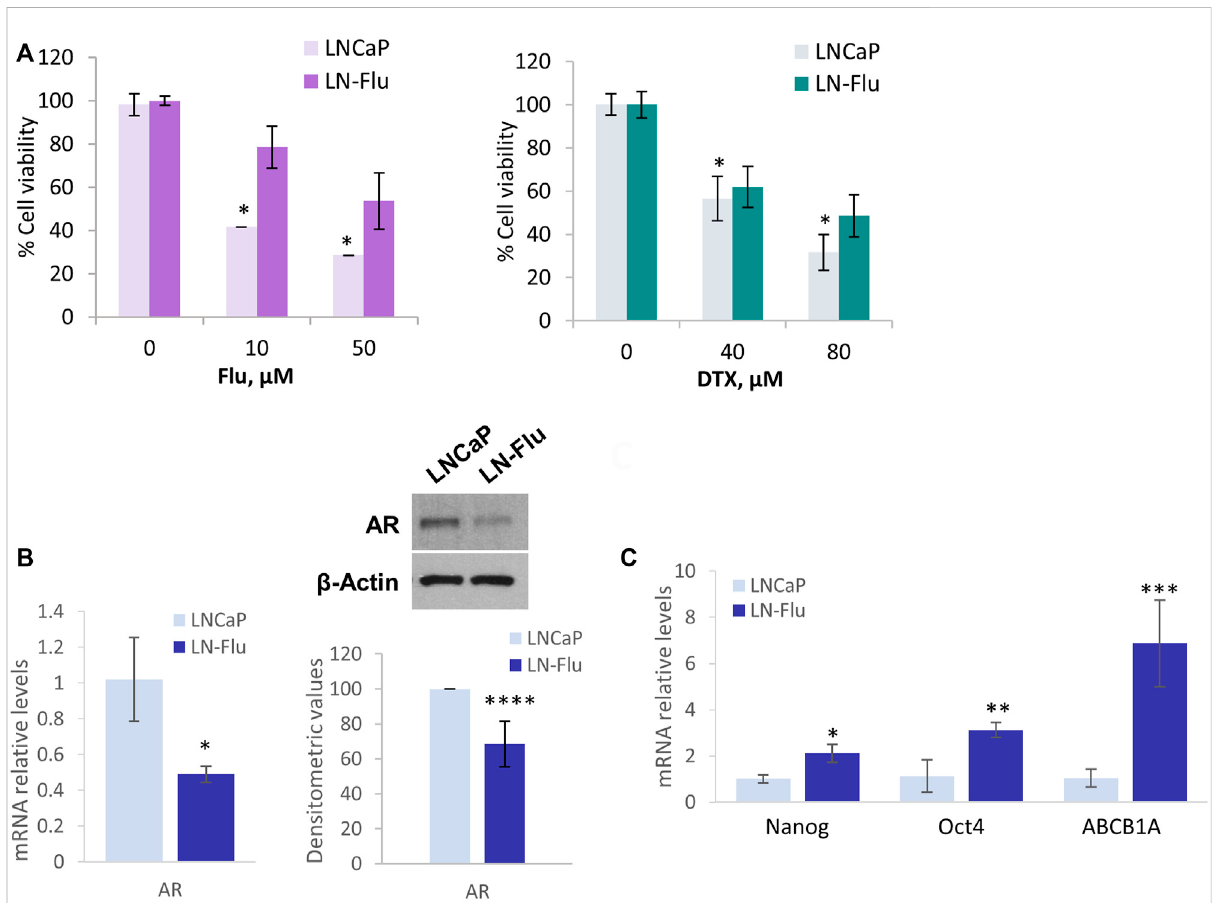
FIGURE 1 LN-Flu cells exhibit chemotherapy resistance and express stem cell markers. LNCaP cells were adapted for six months to grow in the presence of 2 µm 2-hydroxy fl utamide after which they were renamed LN-Flu. (A) MTT Cell viability assay of LNCaP and LN-Flu cells. Cells (1.5 × 10 5 cells/well) were seeded into 12-well plates and treated with the indicated doses of 2-hydroxy fl utamide or docetaxel for 24 h. 100 μ l of MTT [3-(4, 5-dimethyl- 2-thiazolyl)-2, 5-diphenyl-2H-tetrazolium bromide] dye solution was added to each well and incubated at 37 ° C for 1 h. Subsequently, the cells werelysedwith2-propanolandtheopticaldensitywasmeasuredat595 nm.Cellviabilitywascalculatedasthepercentagecomparedtothecontrol cells, which were arbitrarily assigned 100% viability. (B) Levels of AR expression in each cell line, determined by Western blot and qPCR. (C) Levels of stem cell markers expression determined by qPCR. Results are the mean ± S.D. of three independent experiments. * p < 0.05 and ** p